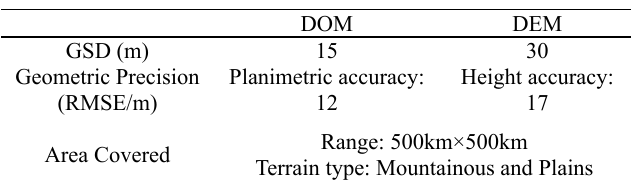
Table 3. Specific information about the reference data